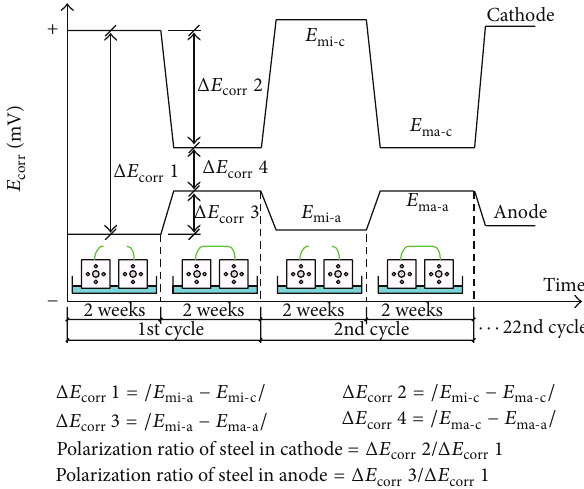
Figure 4: Definition of potential difference of macrocell